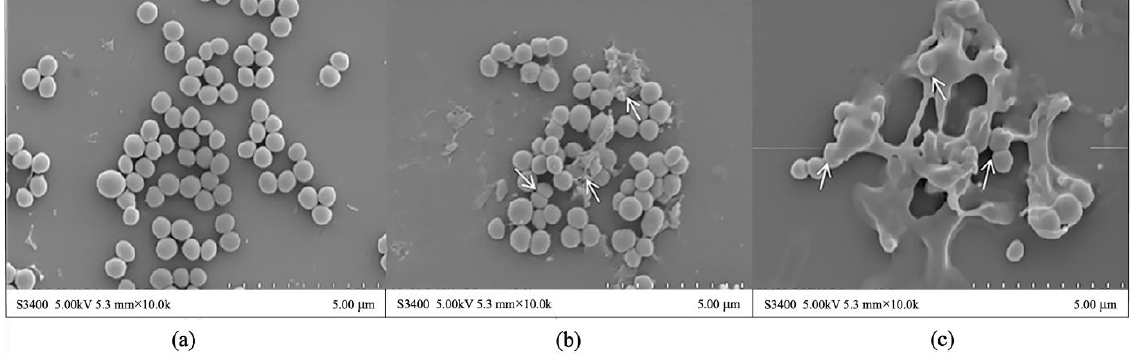
Figure 3. ( a ) SEM images of S. aureus untreated, ( b ) treated by aPDT for 1.296 J/cm 2 , and ( c ) treated by aPDT for 3.24 J/cm 2 .